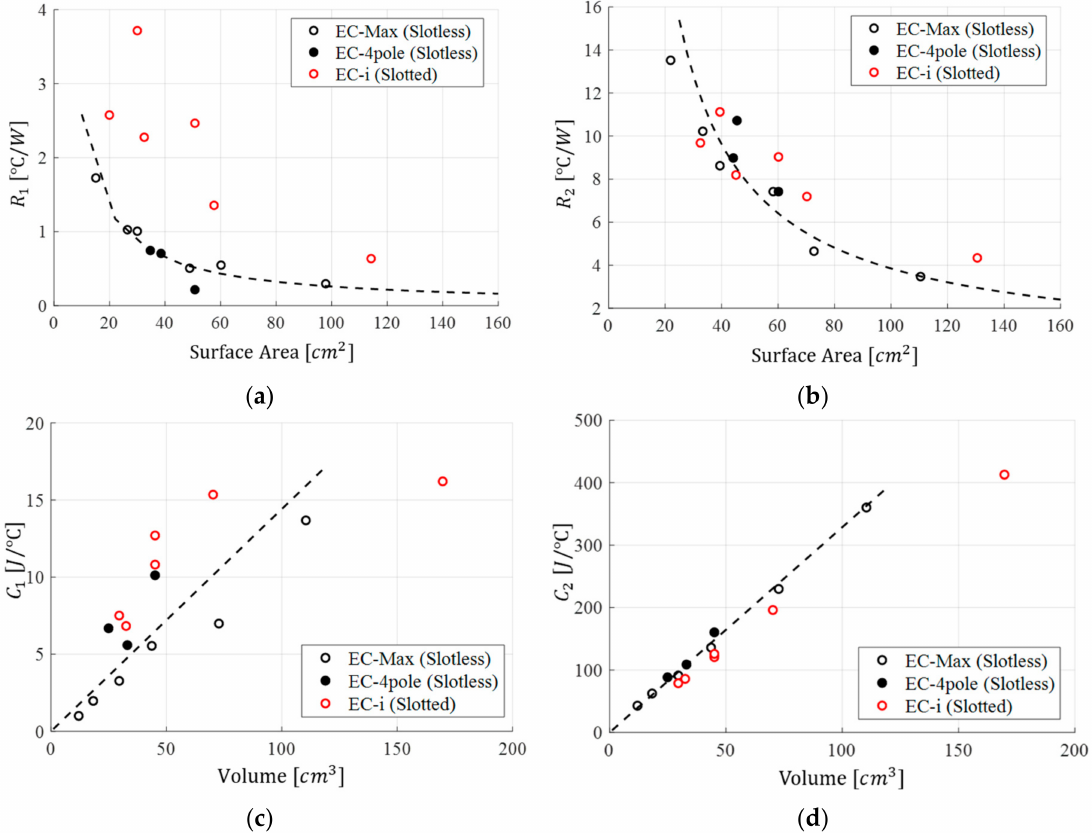
Figure 4. Thermal characteristics of motors compared in Table 1 (dashed lines are drawn based on the average values of the slotless motors in each graph); ( a , b ) Thermal resistance, R 1 , R 2 , against the surface area of the motor and ( c , d ) thermal capacitance, C 1 , C 2 , against the volume of the